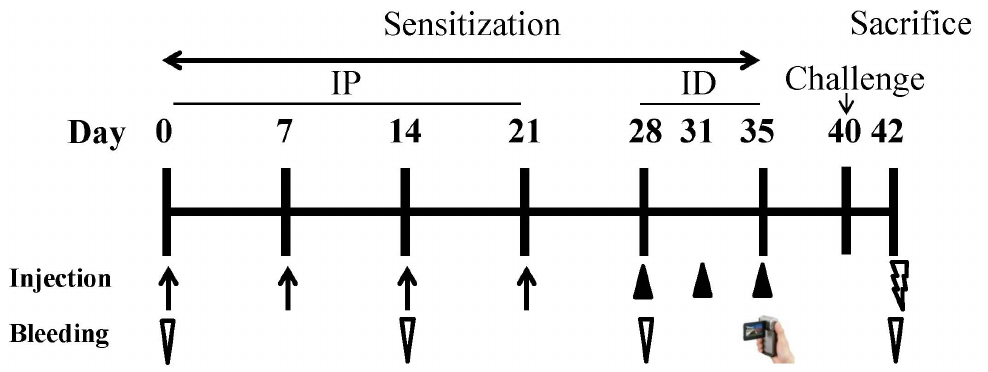
Figure 1. Experimental protocols. BALB/c mice were sensitized intra-peritoneally (IP) with 20 m g of midge extract (group I: midge-sensitized) or PBS (group II: controlled) on days 0, 7, 14 and 21 (n=10 in each group). From day 28 to 35 the mice were intra-dermally (ID) sensitized with 10 m g of midge extract (group I) or PBS only (group II) on days 28, 31 and 35 (arrows). Serum samples were collected on days 0, 14, 28 and 42 as designated with inverted arrow heads. The scratching behaviours were videotaped on day 35 after the final sensitization. The mice were sacrificed on day 42.